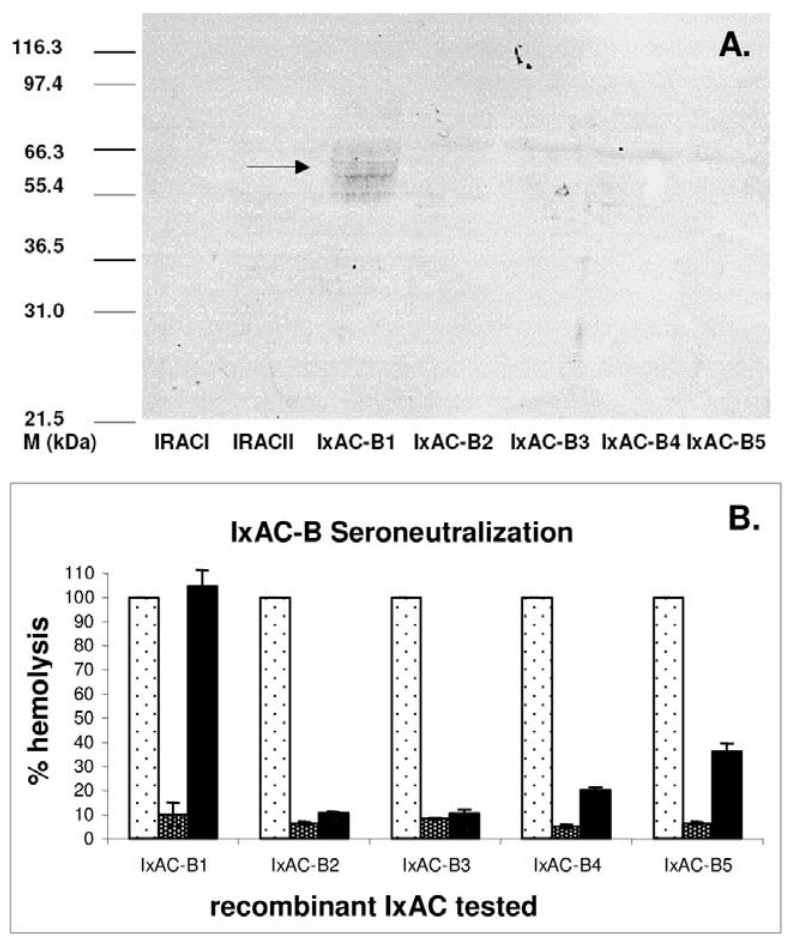
Figure 11. Antigenic specificity of recombinant IxACs fromI.ricinus. Standardised amounts of the seven I. ricinus recombinant IxACs were analysed for antigenic specificity. Panel A. Western blot analysis. The serum from a mouse immunized against IxAC-B1 by genetic immunization followed by a protein boost recognised solely recombinant IxAC B1. M, molecular weight markers (Mark12, Invitrogen). Panel B. Seroneutralization experiments. AP hemolysis assays were conducted with and without the seven recombinant IxACs. 100% hemolysis was obtained in the absence of anticomplement protein (light dotted histogram). Recombinant IxACs alone (dark dotted histogram) or recombinant IxACs plus heat-inactivated sera from mice immunized against IxAC-B1 (anti IxAC-B1, black histogram) or mock immunized mice (anti-PBS, white histogram) were added as indicated. Neutralization of activity as indicated by a recovery of hemolysis, was observed only on IxAC-B1. Upper panels: seroneutralization of IxAC-A subfamily. Lower panel: seroneutralization of IxAC-B subfamily. Error bars represent standard